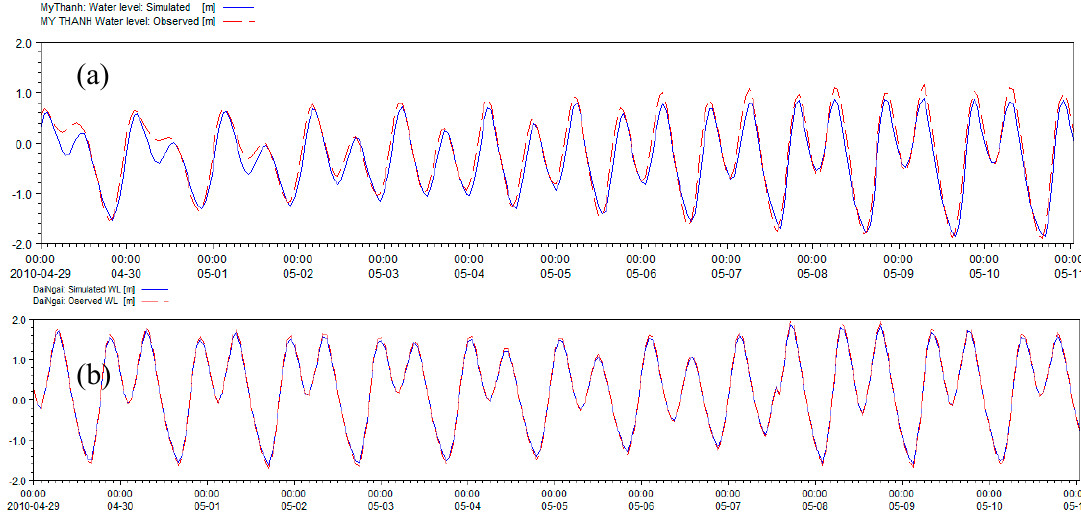
Figure 8. River discharges at Can Tho simulated from the MIKE 11 model for four scenarios. In order to quantify the spatial variations in the salinity concentrations along the river, the minimum and maximum difference in salinity concentrations between the baseline and four